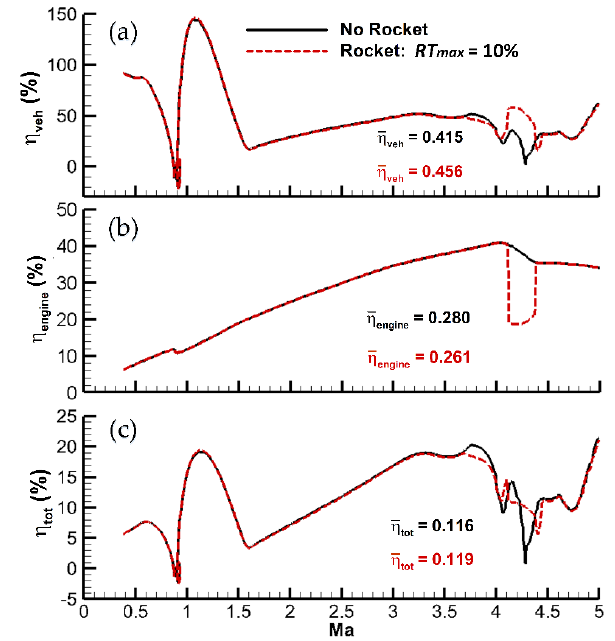
Figure 8. ( a ) Vehicle e ffi ciency profiles; ( b ) Engine e ffi ciency profiles; ( c ) Total e ffi ciency